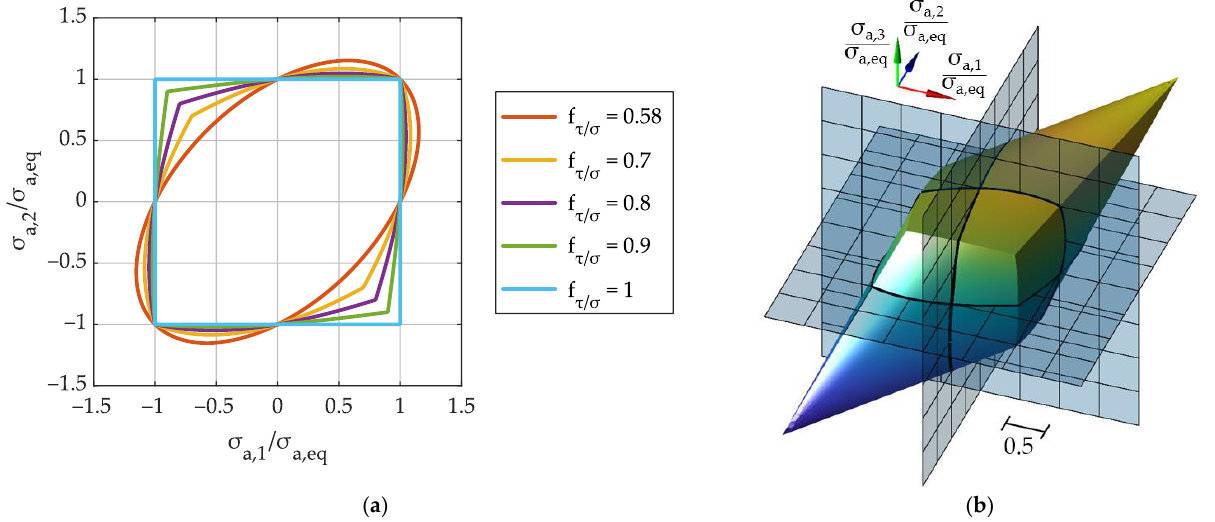
Figure 4. Strength hypothesis according to Lüpfert and Spies for ( a ) different values for f τ σ ⁄ and plane stress states, σ 3 = 0 , and ( b ) f τ σ ⁄ = 0.75 and triaxial stress states.